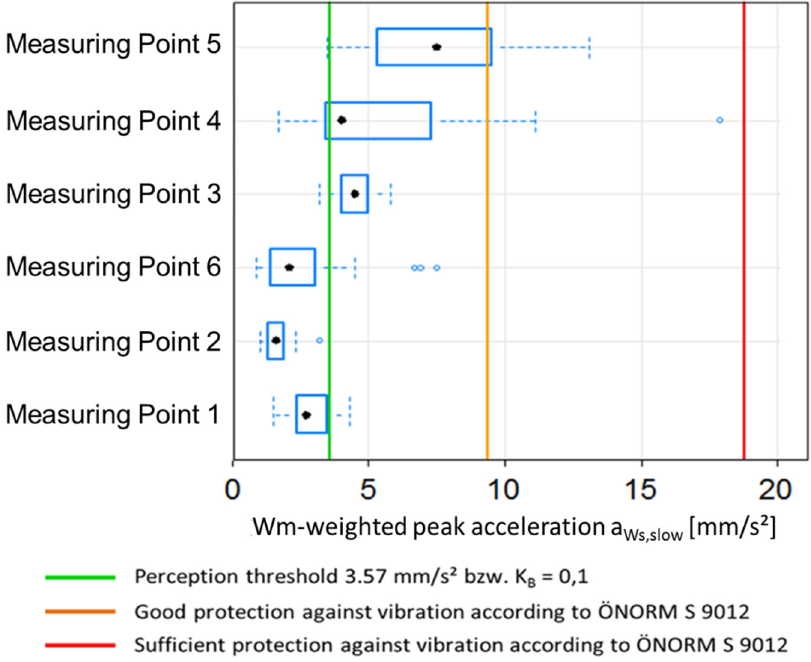
Figure 5. Vibration measurement results for each measurement point—compared with the Austrian